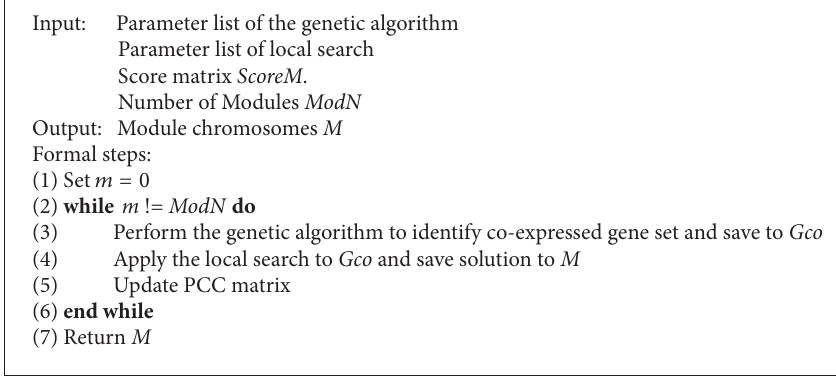
A 1: Pseudocode for module